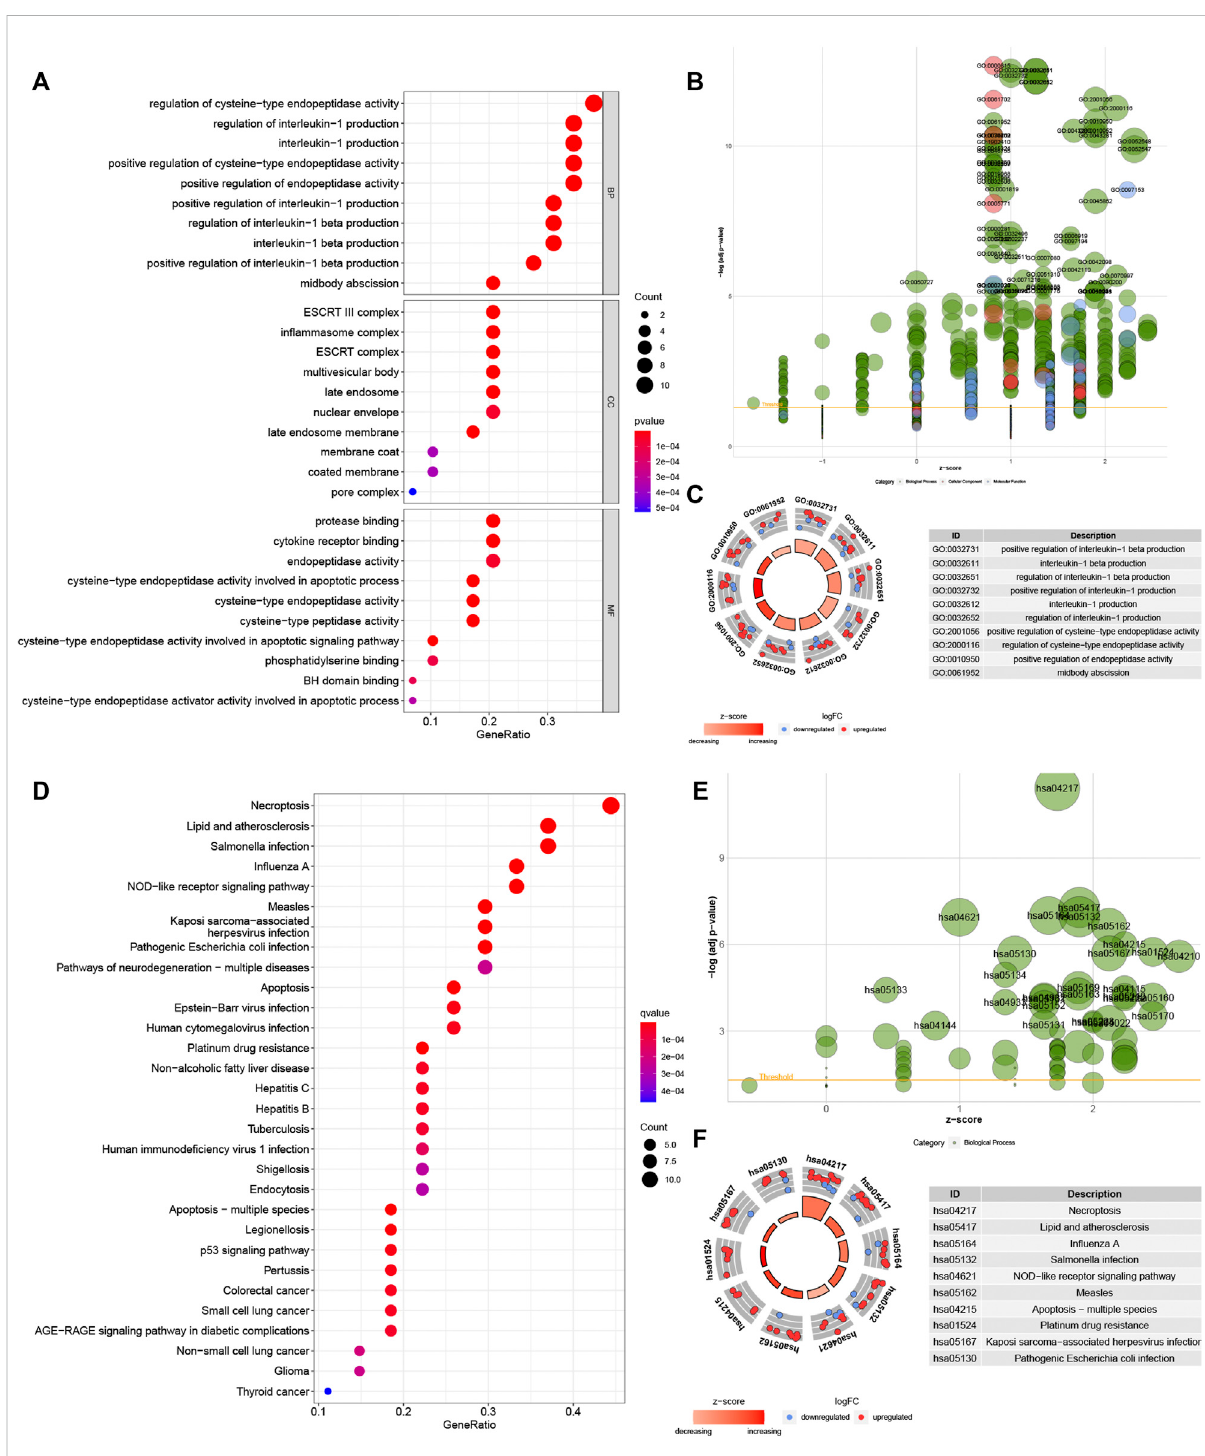
FIGURE 3 Biologicalfunctionalenrichmentresearchofpyroptosis-relatedgenes.FunctionalenrichmentanalysisofPRGs. (A – C) :GOenrichmentofPRGs in biological processes (BP), cellular component (CC) and molecular function (MF). (D – F) : The enriched KEGG pathways of PRGs. PRG, pyroptosis- related gene; GO, gene ontology; KEGG, Kyoto Encyclopedia of Genes and